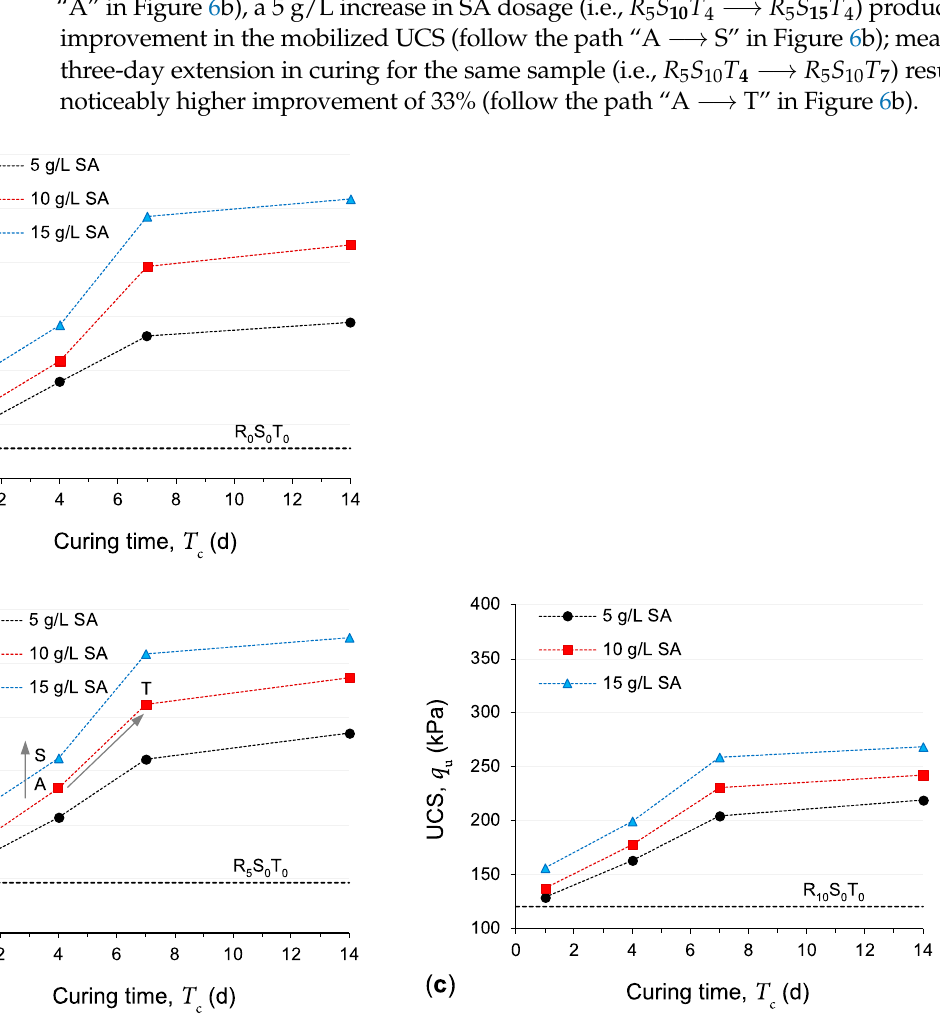
Figure 6. Variations of the UCS parameter against curing duration for the samples ( a ) R 0 S y T z , ( b ) R 5 S y T z and ( c ) R 10 S y T z , where y = {5, 10, 15} and z = {1, 4, 7, 14}.